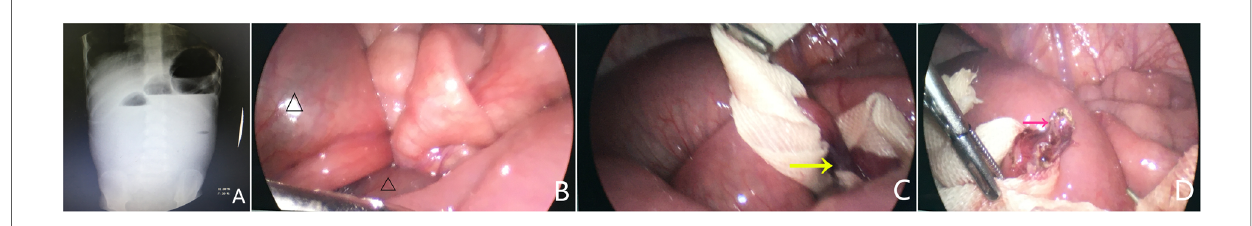
FIGURE 1 Plain abdominal radiography and intraoperative fi ndings revealed complete SBO ( A ), dilated small intestine ( B , △ ), a single adhesive band ( C , yellow arrow), and adhesiolysis completion ( D , pink arrow) in a 6-year-old boy who had undergone a prior appendectomy due to acute perforated appendicitis.